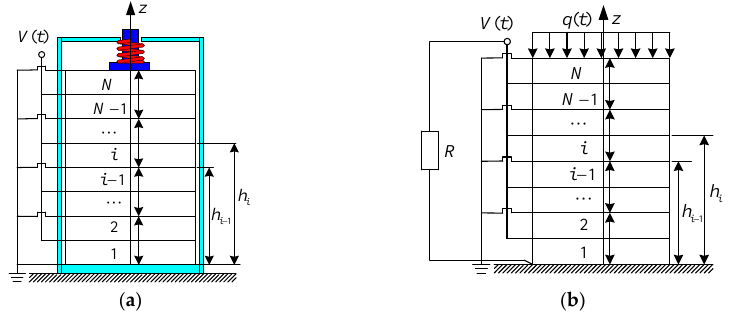
Figure 1. Schematic of the piezoelectric stack: ( a ) under a voltage load (Model A) and ( b ) under a uniformly distributed load (Model B).